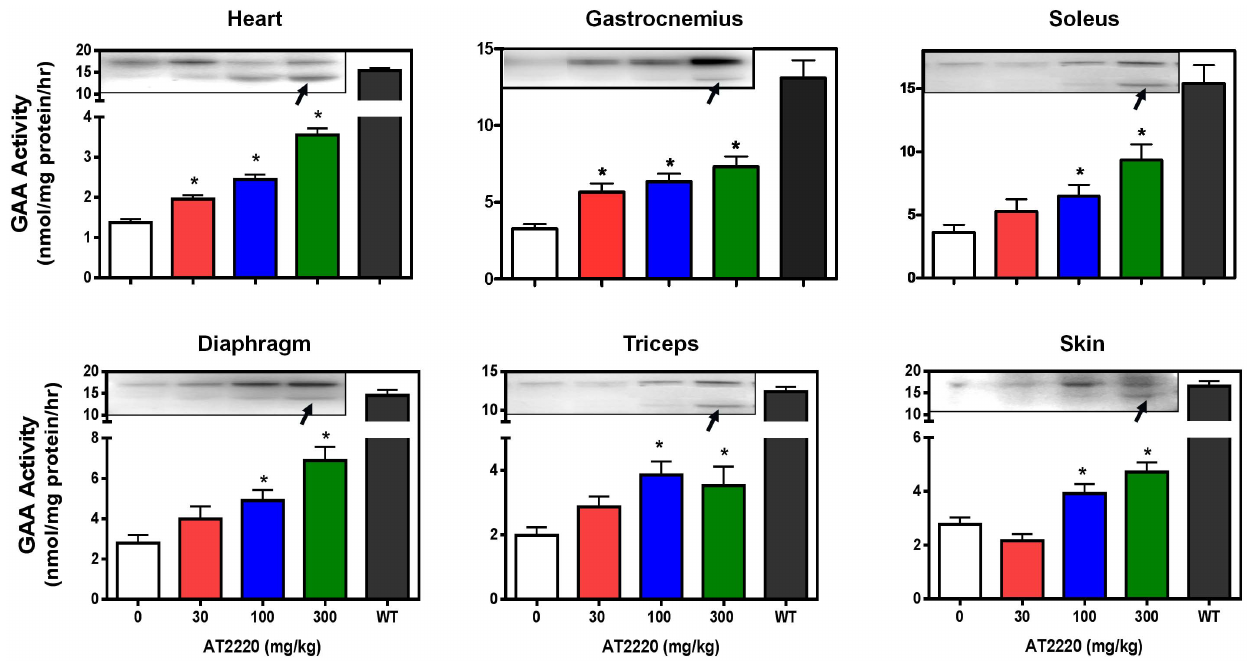
Figure 6. Oral AT2220 administration increases GAA activity in hP545L GAA Tg/KO mouse tissues. Eight-week old male hP545L GAA Tg/ KO mice were administered AT2220 ad libitum in drinking water for four weeks at the indicated doses. GAA activity was measured in homogenates of heart, gastrocnemius, soleus, diaphragm, triceps, and skin as described in ‘Materials and Methods’. The data presented represent the mean 6 SEM of 7 mice/group analyzed in triplicate. Significant increases in GAA activity are reported as *p , 0.05 vs. untreated, t-test. The effect was also significant for a linear trend, indicating a dose-dependent increase in GAA activity (post-hoc analysis, p , 0.05). Insets . Tissue GAA protein levels were determined by Western blotting. The upper band represents the 110 kDa precursor isoform. The appearance of the 76 kDa mature lysosomal form is indicated by the dark arrow. Each lane on each Western blot contains the tissue homogenate from a single animal. The Western blot shown is representative of two experiments, each of which included a different mouse from each group.